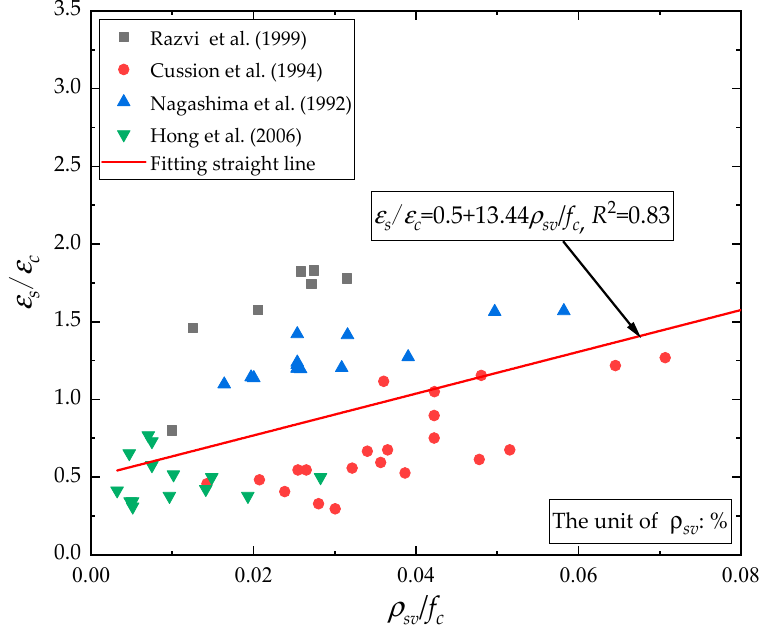
Figure 9. Relationship between ε s / ε c and ρ sv / f [8,9,20,38]. Using k ρ /f as the basic parameters, the empirical formulae for the ties strain were obtained using regression analysis in which the concrete and ties yield strength ranges were 50–115 MPa and 392–1387 MPa, respectively.